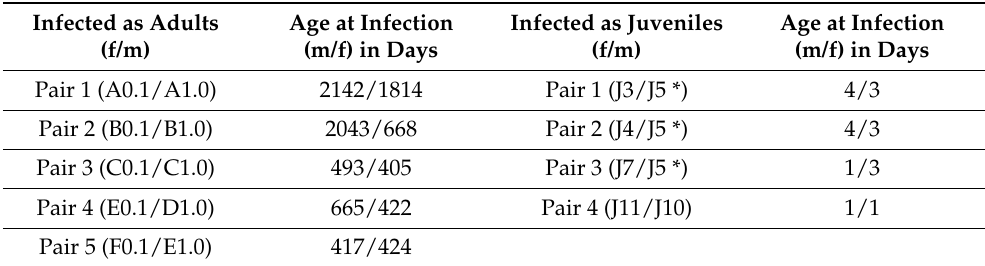
Table 2. Pairs of adult and juvenile infected birds. Those marked with * were nesting in a group, and the male J5 had several